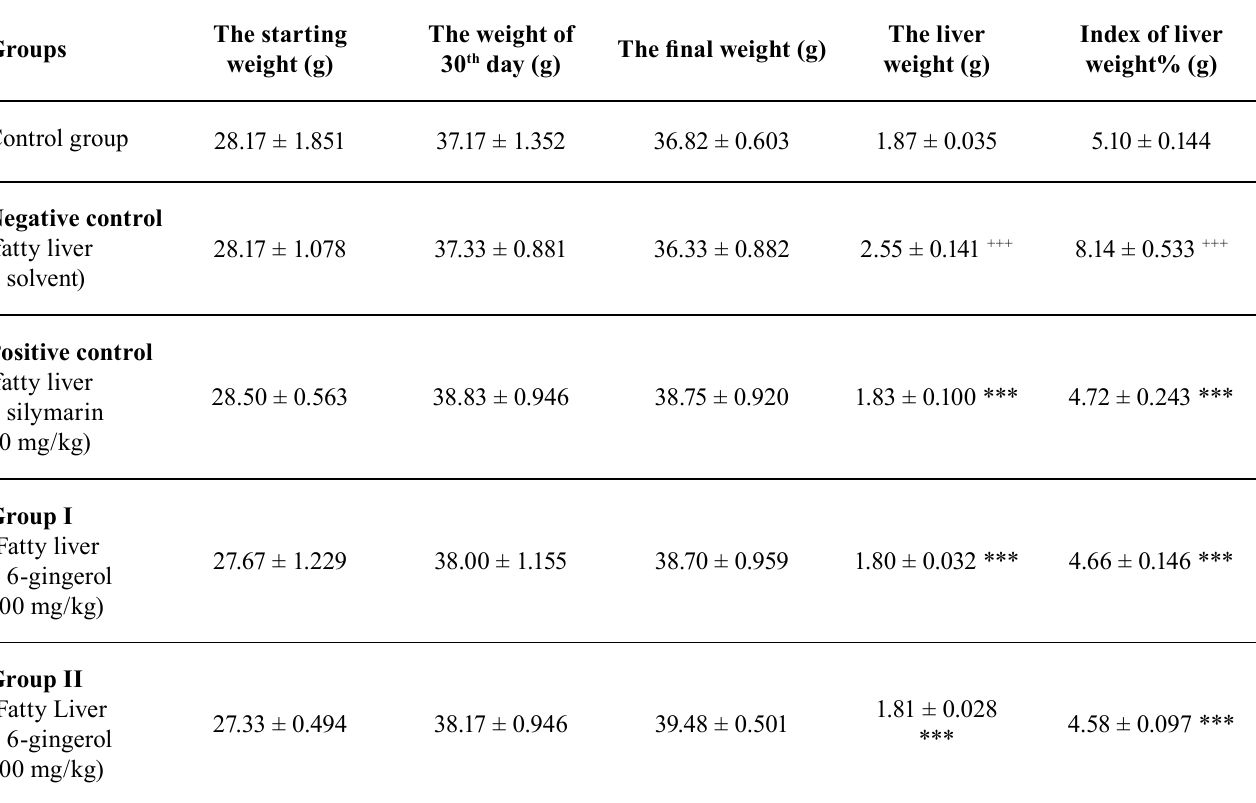
TABLE IV – The body weight and index of liver weight of mice receiving control diet, high-fat diet, and 6-gingerol. n =